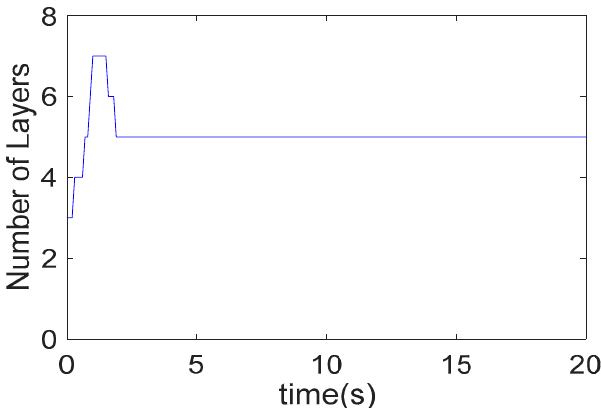
Figure 26. Number of layers using self-evolving algorithm for Case 4.